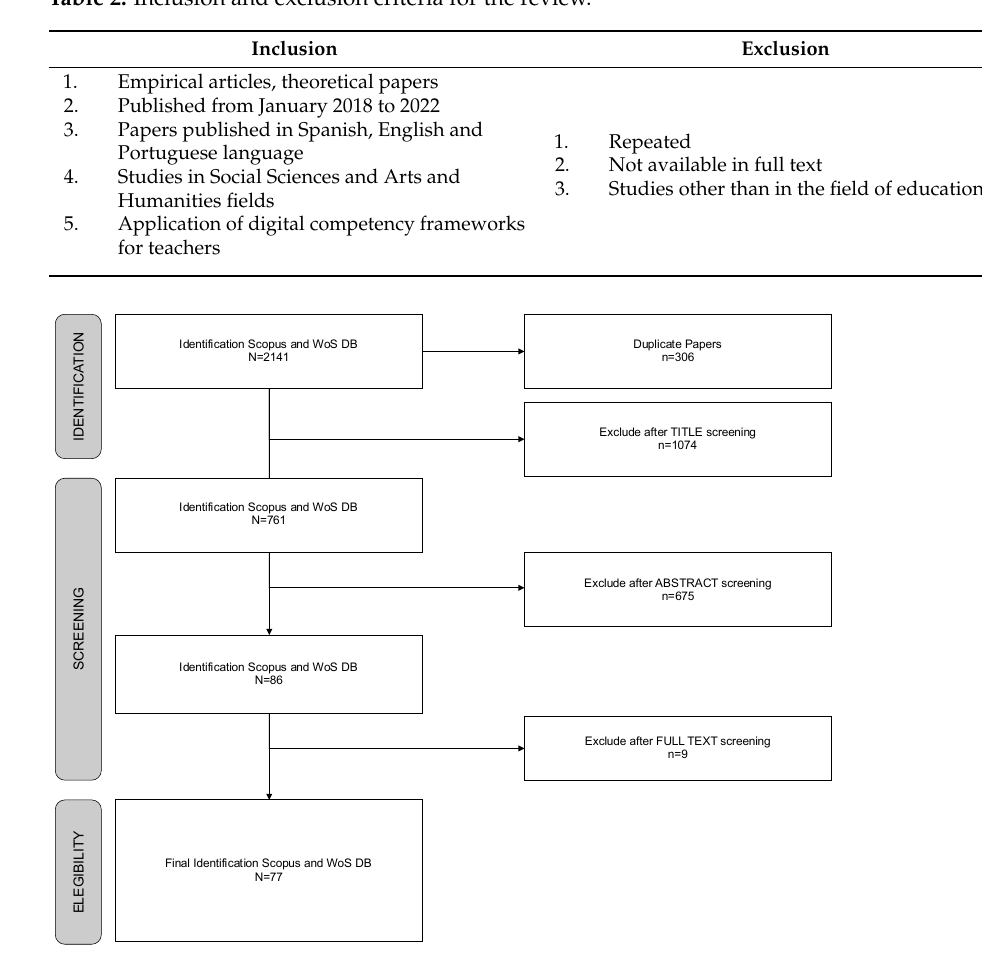
Figure 1. Articles found in the Scopus database (as of November 2022). Table 2. Inclusion and exclusion criteria for the review.